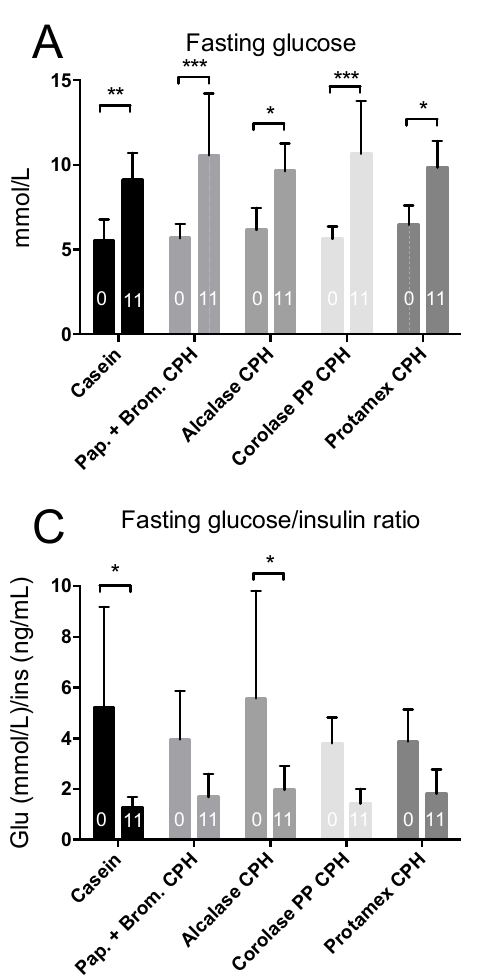
Figure 3. Fasting glucose and insulin levels in C57BL/6 mice at baseline (0 weeks) and after 11 weeks of feeding with 19 E% casein- or 9.5 E% casein and 9.5 E% CPH-high fat/high-sucrose diets. ( A ) The fasting blood glucose level. ( B ) The fasting plasma insulin level. ( C ) The fasting glucose and insulin ratio. Mean values with standard deviation are shown ( n = 5–6). Significant difference between group mean values at 0 and 11 weeks was determined by one-way ANOVA with Fisher’s LSD test (all p > 0.05). Significant difference between mean values at 0 and 11 weeks within each group was determined by two-way ANOVA and Sidak’s multiple comparisons test (* p < 0.05, ** p < 0.01, *** p < 0.001).